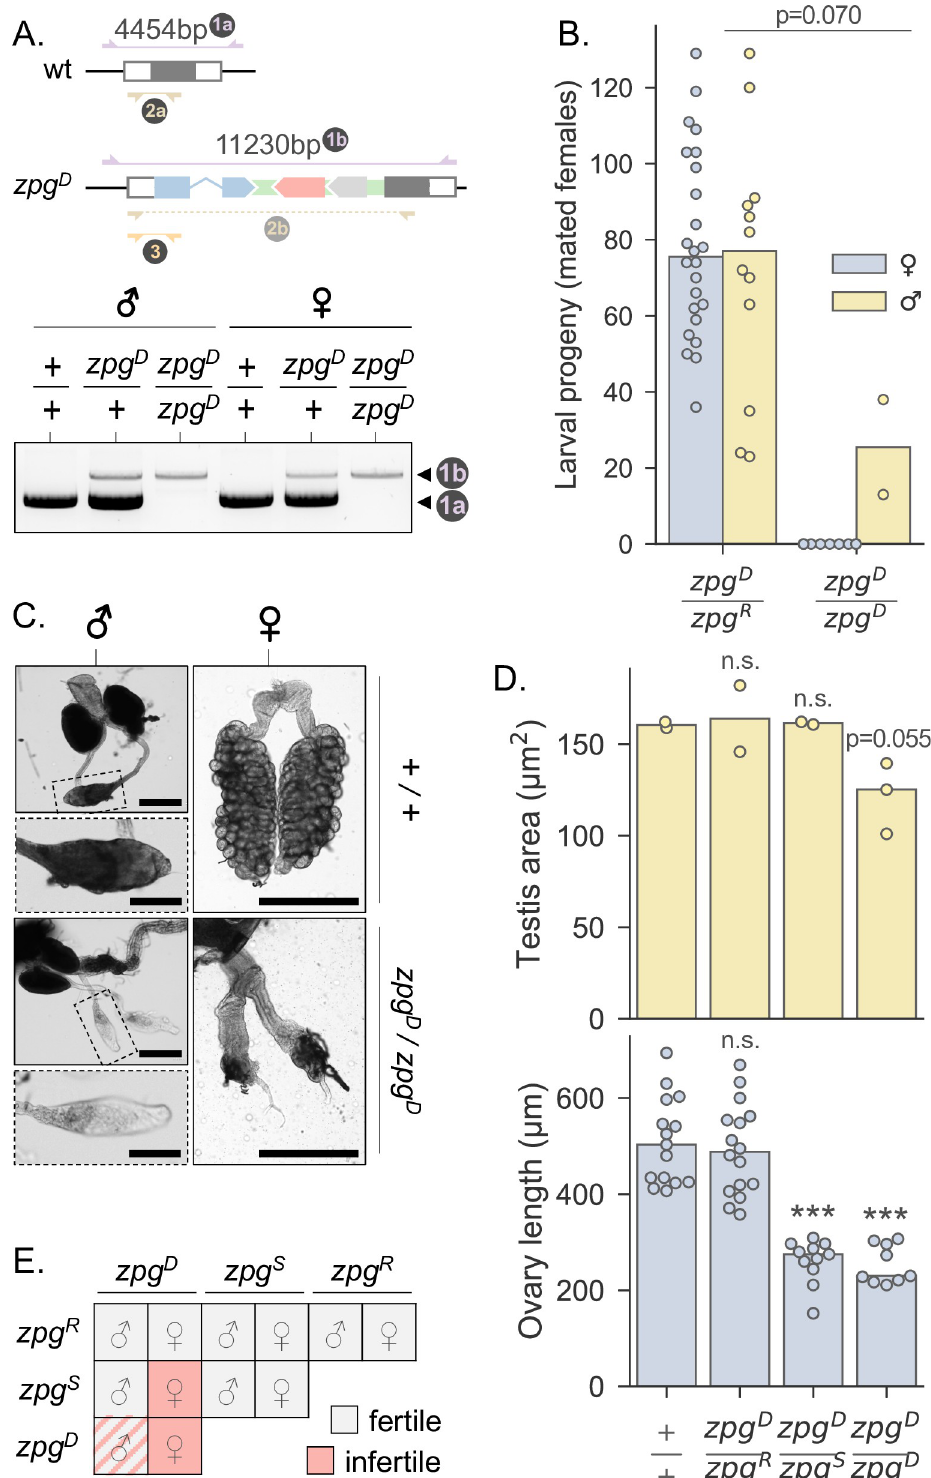
Fig 3. zpg D homozygotes are viable, but germline homozygosity results in sterility. A : Molecular PCR assay to differentiate the zpg genotypes of adult mosquitoes. Primers in set 1 (purple) bind outside the original homology arms. These were used to confirm that zpg D had integrated at the endogenous gene, and to identify adult wt,